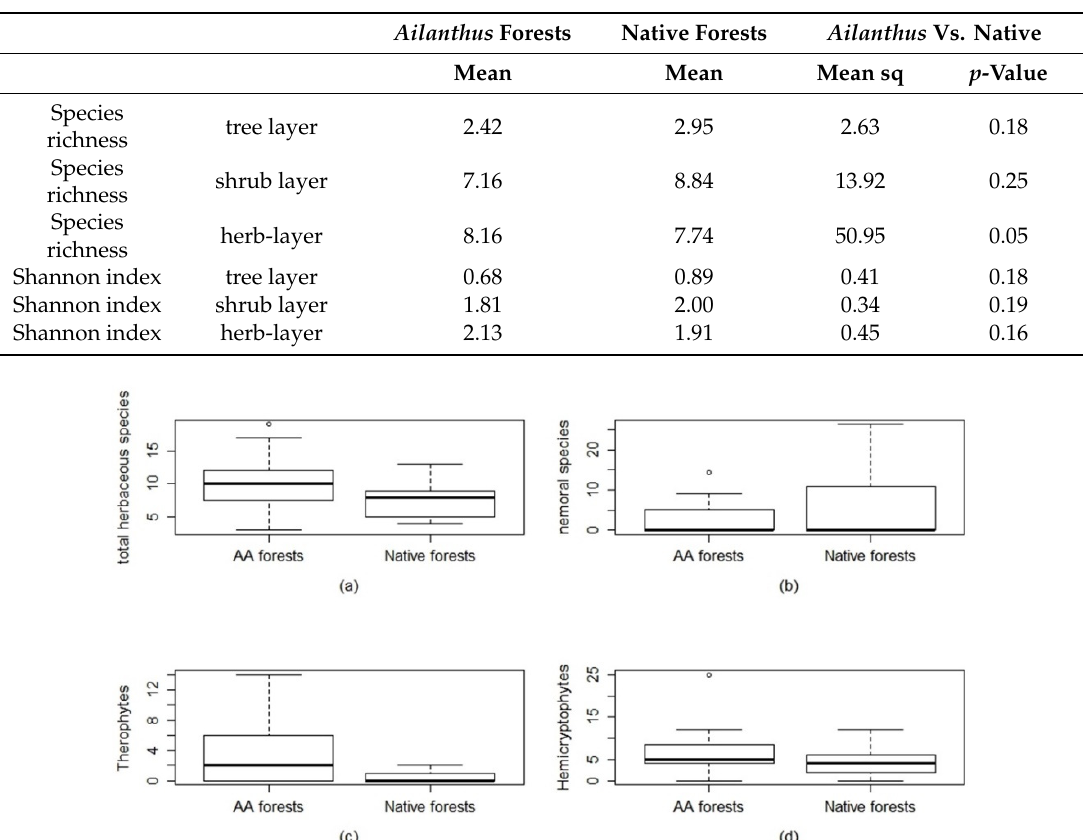
Figure 2. Comparison of the herbaceous layer diversity and life forms between A. altissima (AA forests) and Native forests. ( a ) total herbaceous species diversity ( p value = 0.05 * ), ( b ) nemoral species diversity ( p value = 0.065), ( c ) therophyte species ( p value = 0.006 ** ), ( d ) hemicryptophyte species ( p value = 0.085). p level: *** p < 0.001; ** p < 0.01; * p ≤ 0.05. Significant values are in bold.